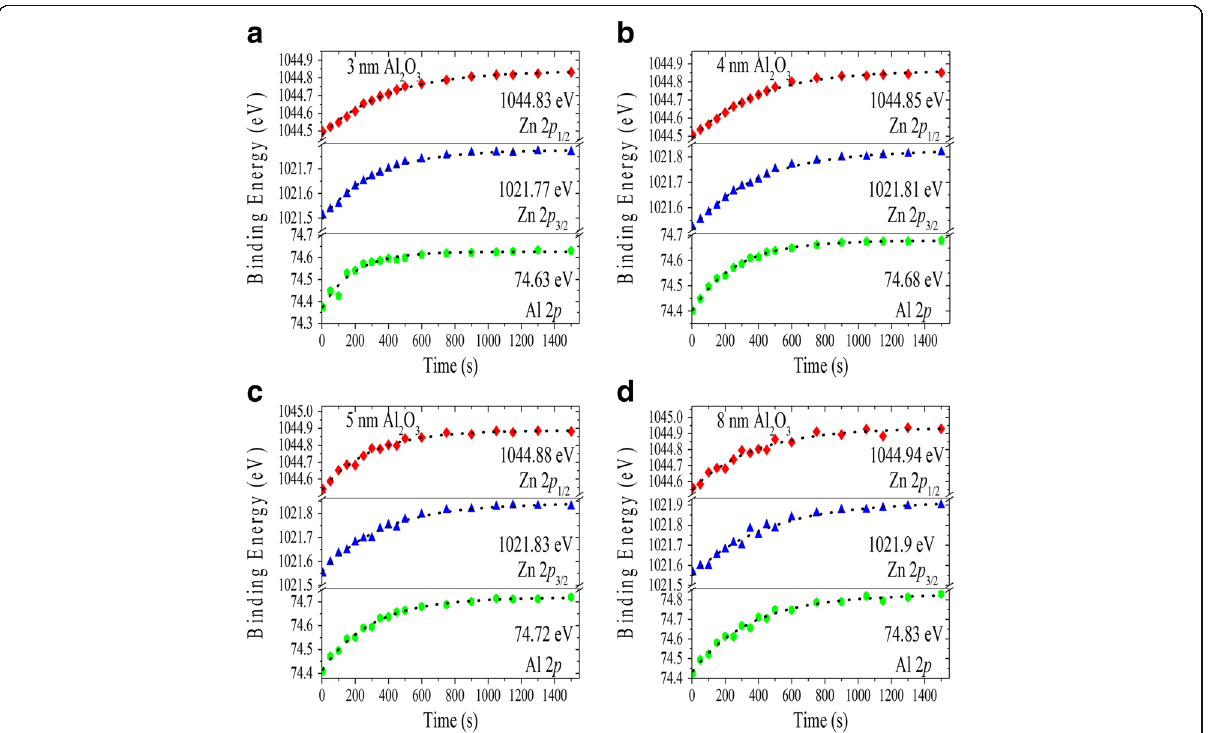
Fig. 5 Time-resolved plots showing the respective binding energies vs. X-ray irradiation time for a 3 nm, b 4 nm, c 5 nm, and d 8 nm Al 2 O 3 films on Zn 0.8 Al 0.2 O on Si substrates, with application of a low-energy electron flood